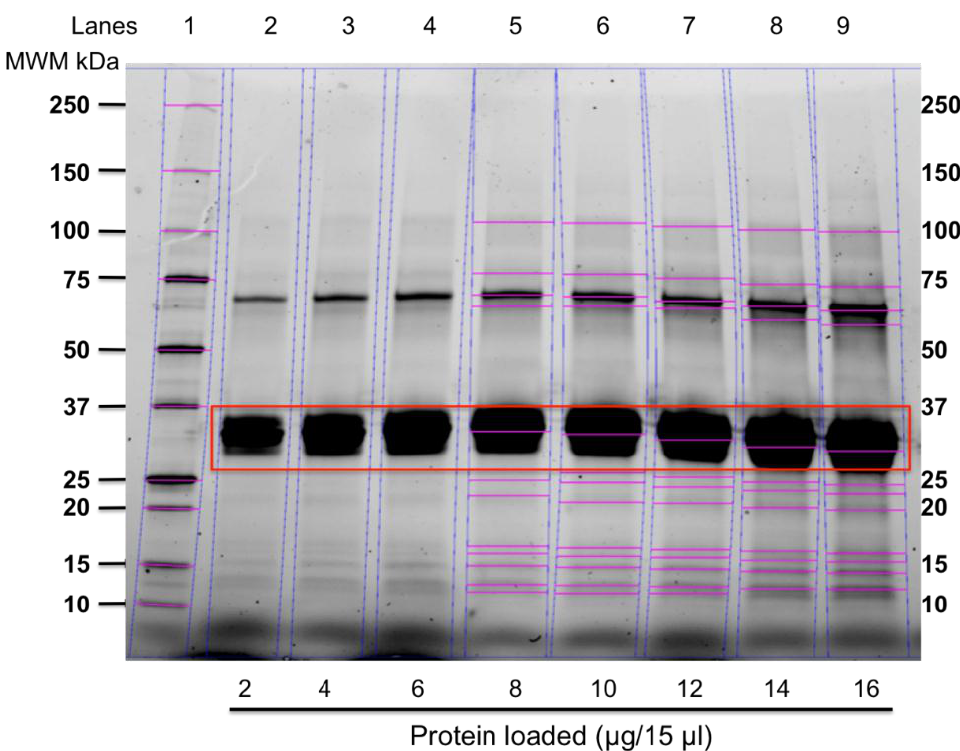
Figure 2. SDS-PAGE of the cow milk protein utilized for sensitization. Lane 1: molecular weight markers (MWM); lanes from 2 to 9: cow milk protein at different concentrations. The lines in the gel show the molecular weight markers (lane 1) and the bands included in the densitometric analysis to determine the percentage of caseins (lanes from 5 to 9). The red box indicates the caseins molecular weight region.